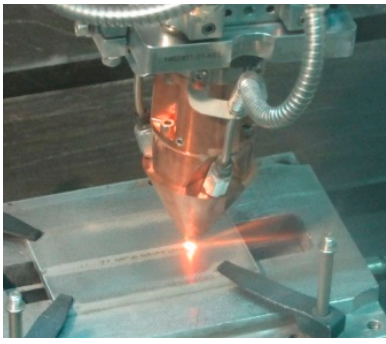
Figure 2. Laser head performing DED over a flat surface. Table 2. Main technical features of the laser source.